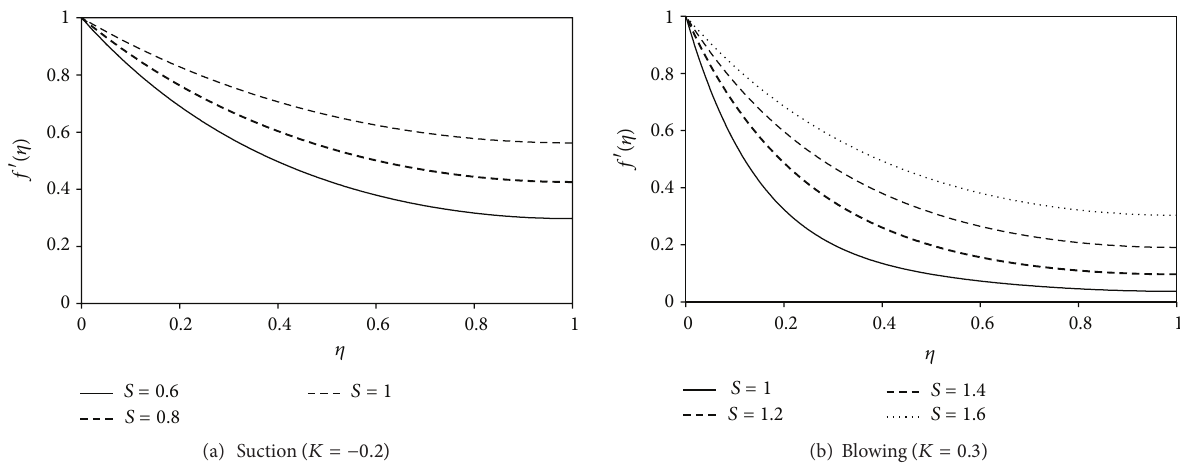
Figure 5: The effect of unsteadiness parameter 𝑆 on the velocity distributions 𝑓 󸀠 (𝜂) using 10th-order HAM approximation when Pr = 1 .